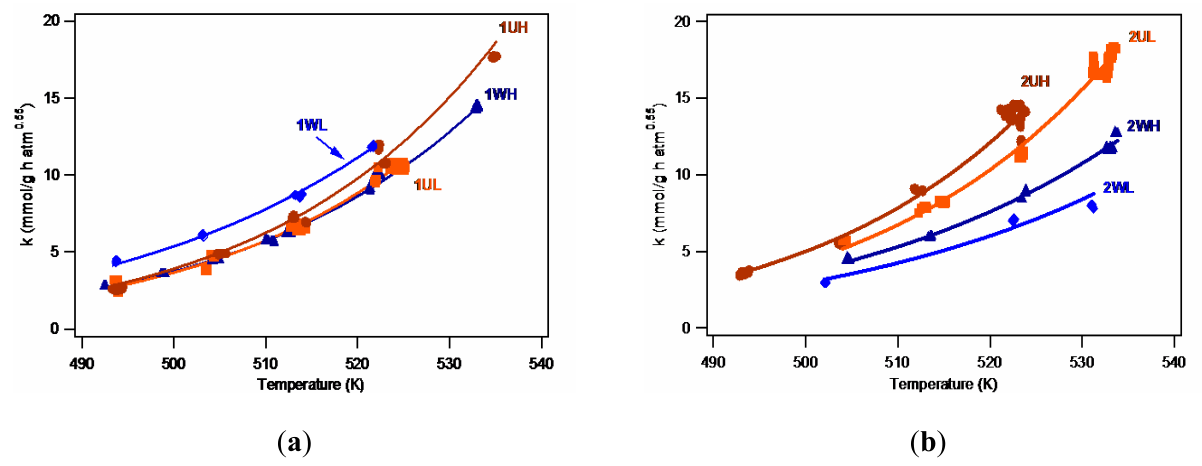
Figure 6. Rate constant as a function of temperature for ( a ) 1S and ( b ) 2S catalyst kinetic data sets.